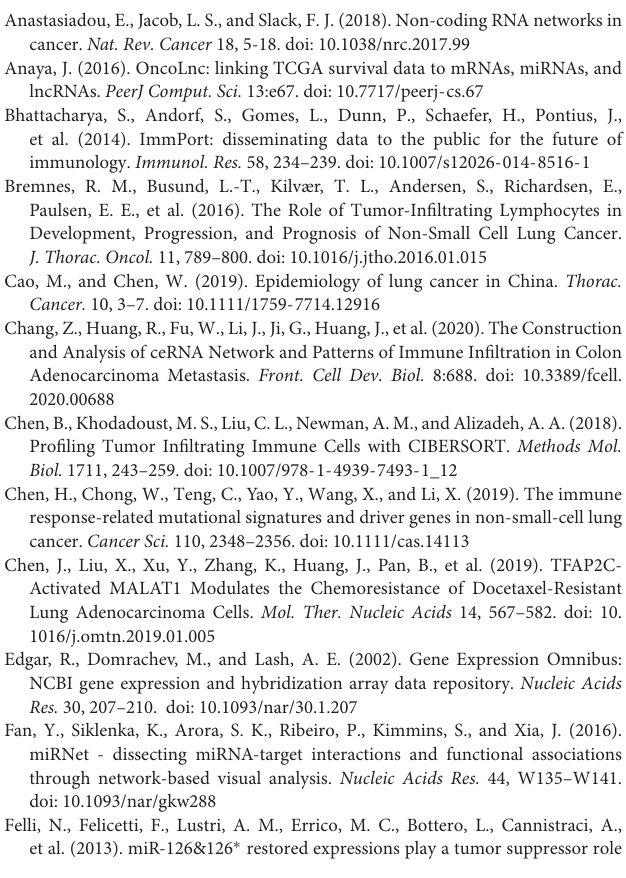
by directly regulating ADAM9 and MMP7 in melanoma. PLoS One 8:e56824. doi: